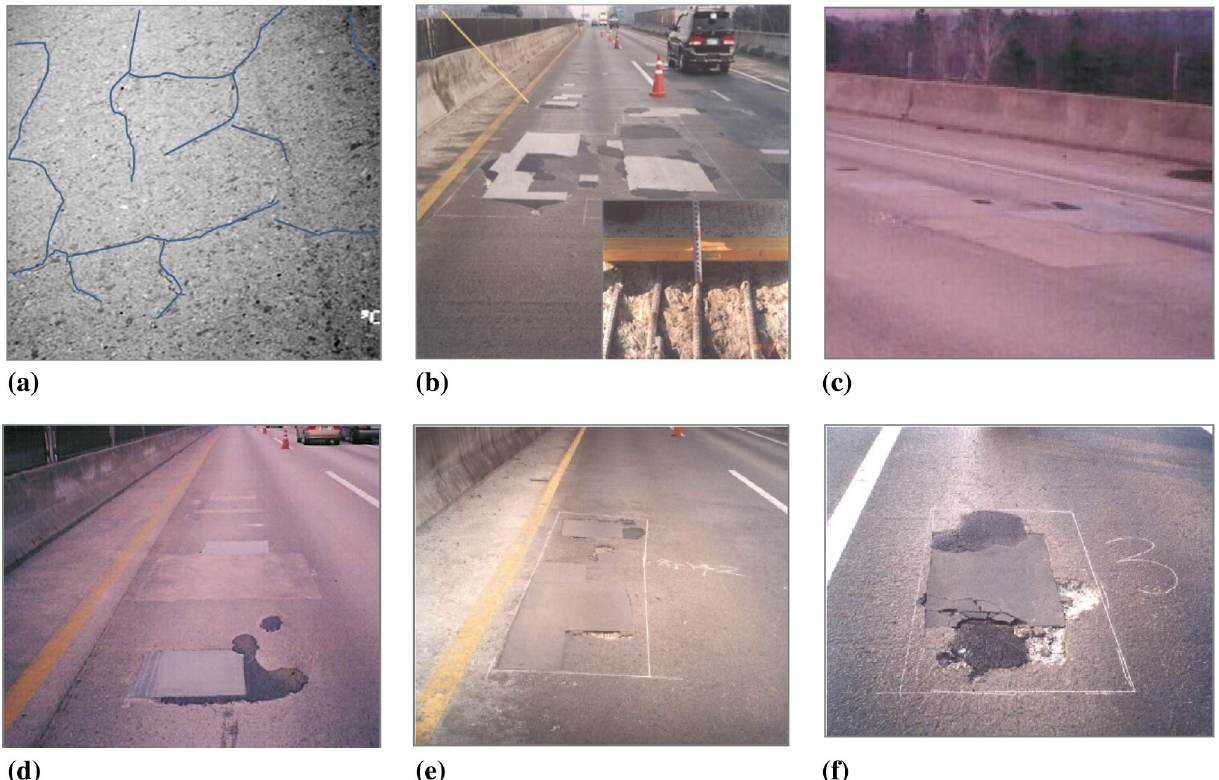
Fig. 12 Typical deterioration of concrete on the validation concrete bridge deck: a distributed surface-breaking crack [span 2 and lane 2, JB-3N], b region repaired by rapid-set concrete and epoxy patch [span 3 and lane 2, JB-3N], c region repaired by rapid-set concrete and epoxy patch [span 4 and lane 2, JB-3N], d region repaired by rapid-set concrete and epoxy patch [span 5 and lane 1, JB-3N], e spalling [span 2 and lane 1, JB-3S], and f spalling and region repaired by epoxy patch [span 5 and lane 2,